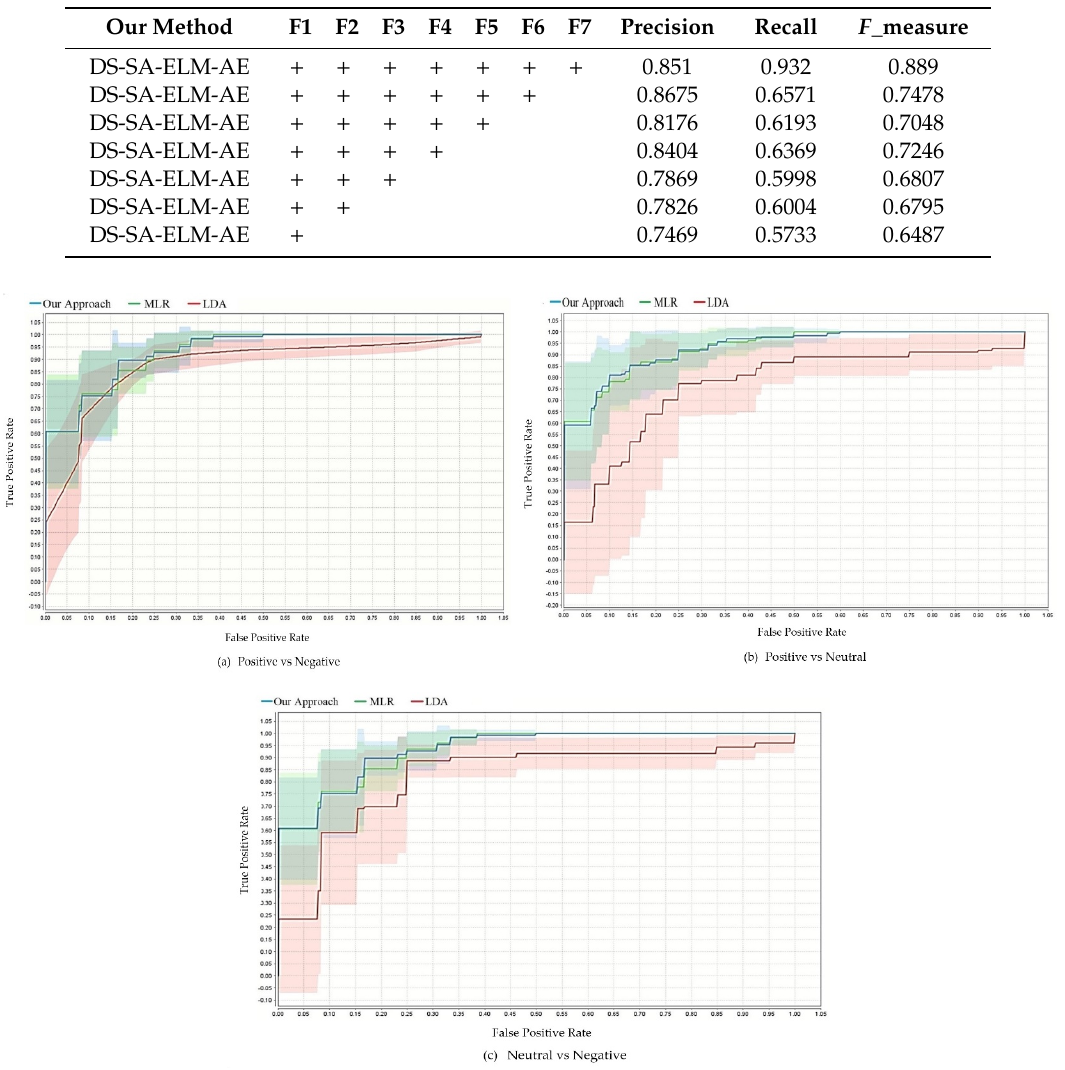
Figure 8. Receiver operating curves (ROC) curves comparison with the inherent multi ‐ class